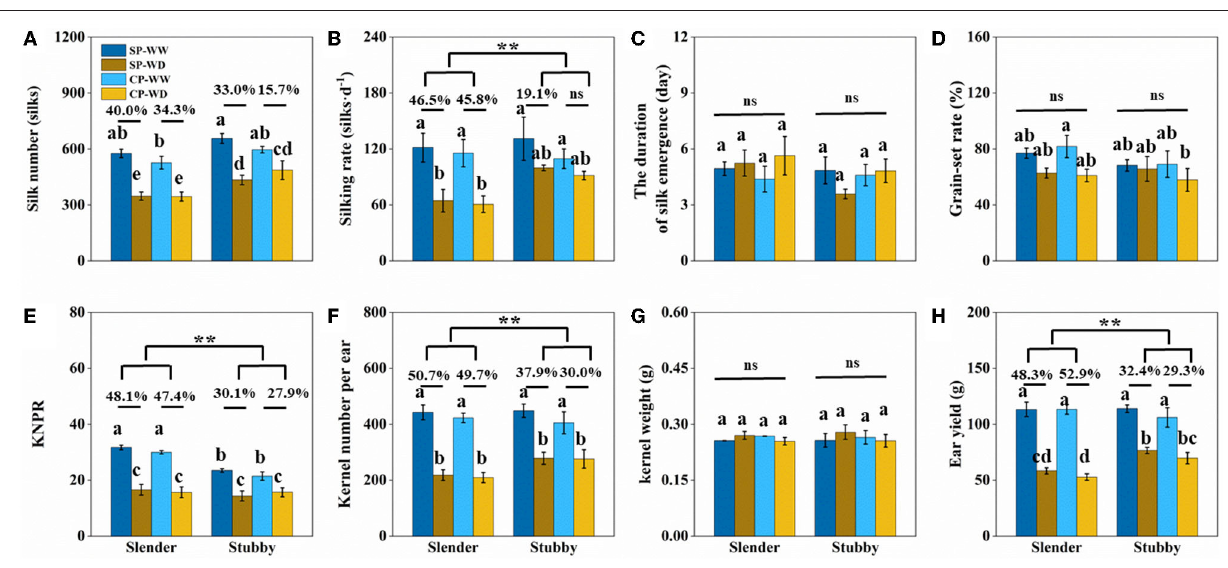
FIGURE 7 | (A–H) Traits of silk and yield of two ear types (slender: hybrids 11, 13, 15, and 16; stubby: hybrids 18, 20, 22, and 24) with the similar silk number, kernel number per ear, and ear yield in the WW. One-way ANOVA followed by Duncan’s new multiple range test, n ≥ 3; letters (a, b, and c) indicate significant differences ( p < 0.05). Data represent the change rate of water-deficit treatments compared to well-watered treatments. Asterisks indicate that the loss rate between slender and stubby ear types was significantly different ( t -test, n ≥ 4: ** p < 0.01). d, day; ns, no significance; SP, synchronous pollination; CP, continuous pollination; WW, well-watered treatment; WD, water-deficit